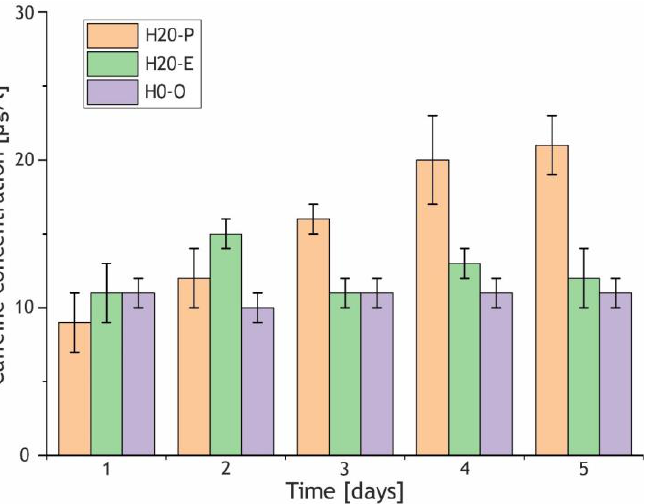
Figure 15. Concentration of caffeine in the release medium for the H20-P, H20-E, and H0-C samples. Data are represented as means ± SD (n = 3).